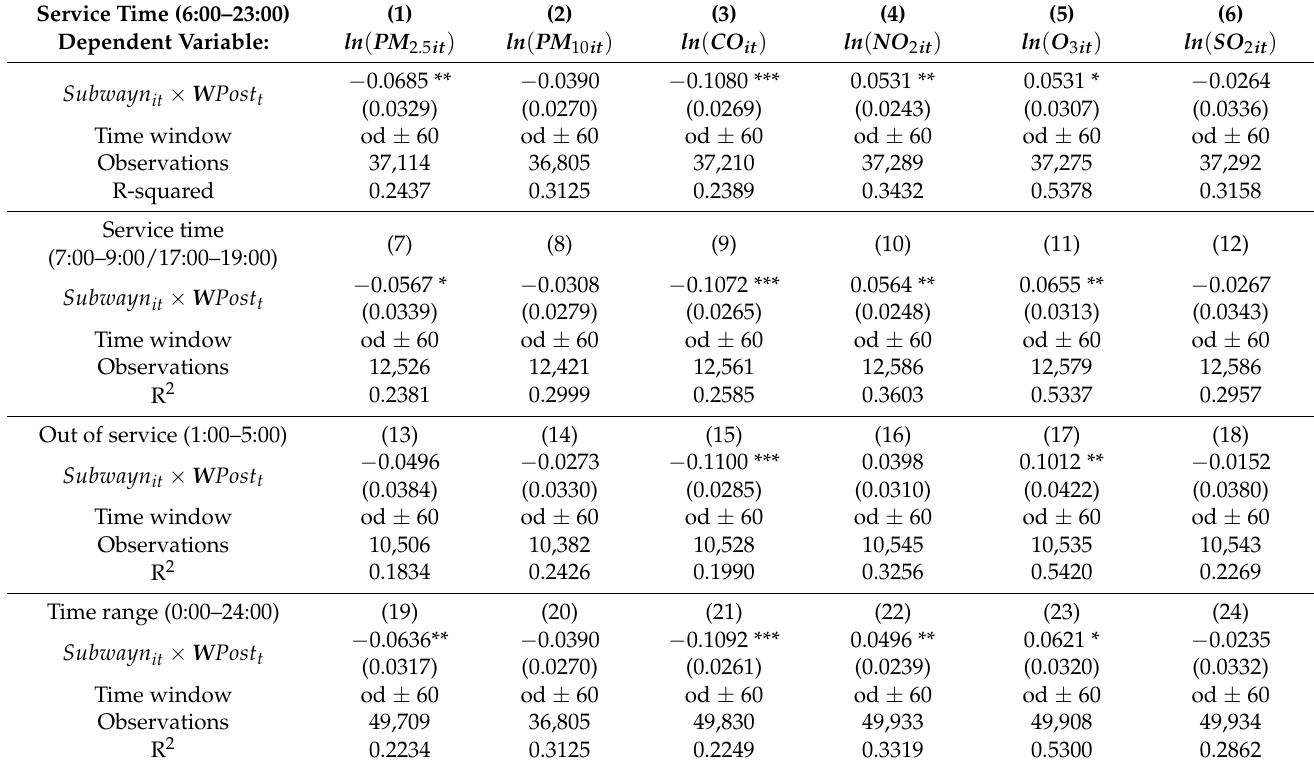
Table 6. DID-based estimation of different time intervals and types of air